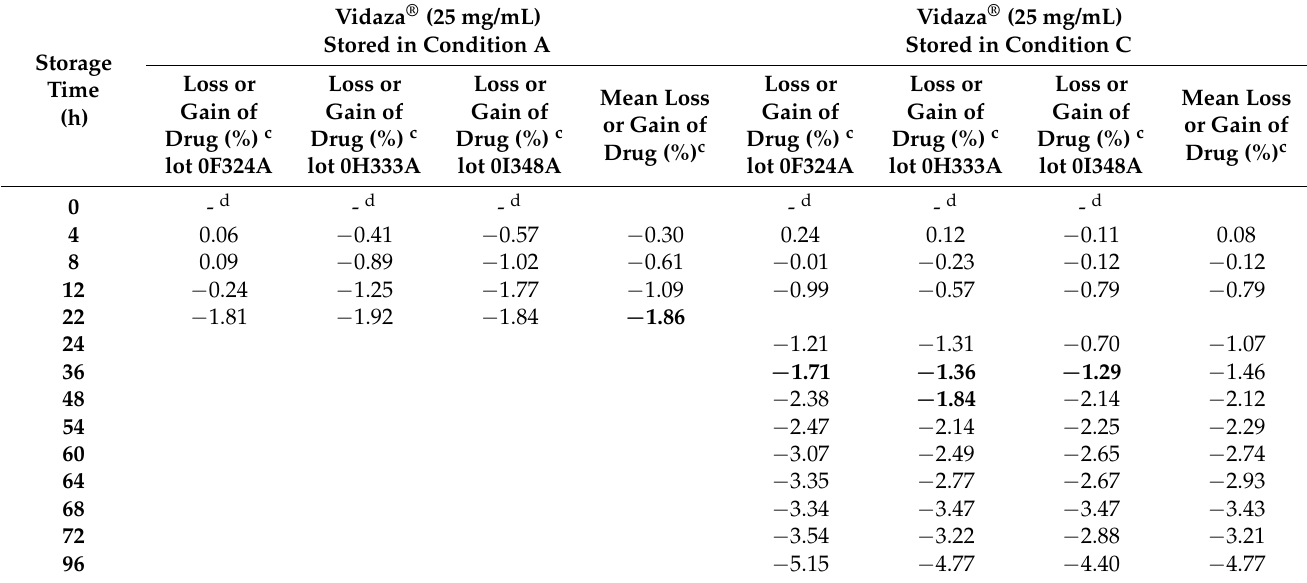
Table 4. Loss or gain of Azacitidine in three Vidaza ® (25 mg/mL) preparations stored in conditions A and C at each time